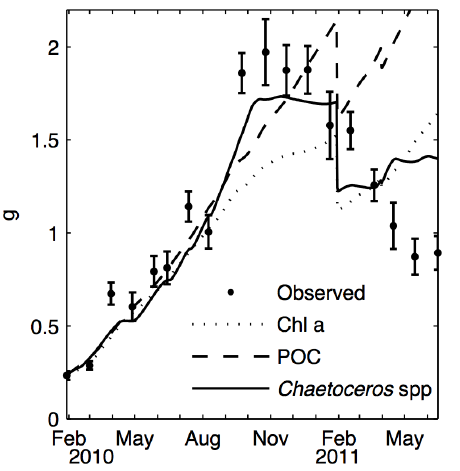
Figure 4. Comparisons of observed and modeled dry flesh mass (DFM) with different food inputs. Observations (dots) and DEB simulations (lines) are based on in situ measurements of food sources, with chl a (dashed line), POC (dotted line) and Chaetoceros spp. separately (solid line). The latter produced the best fit.